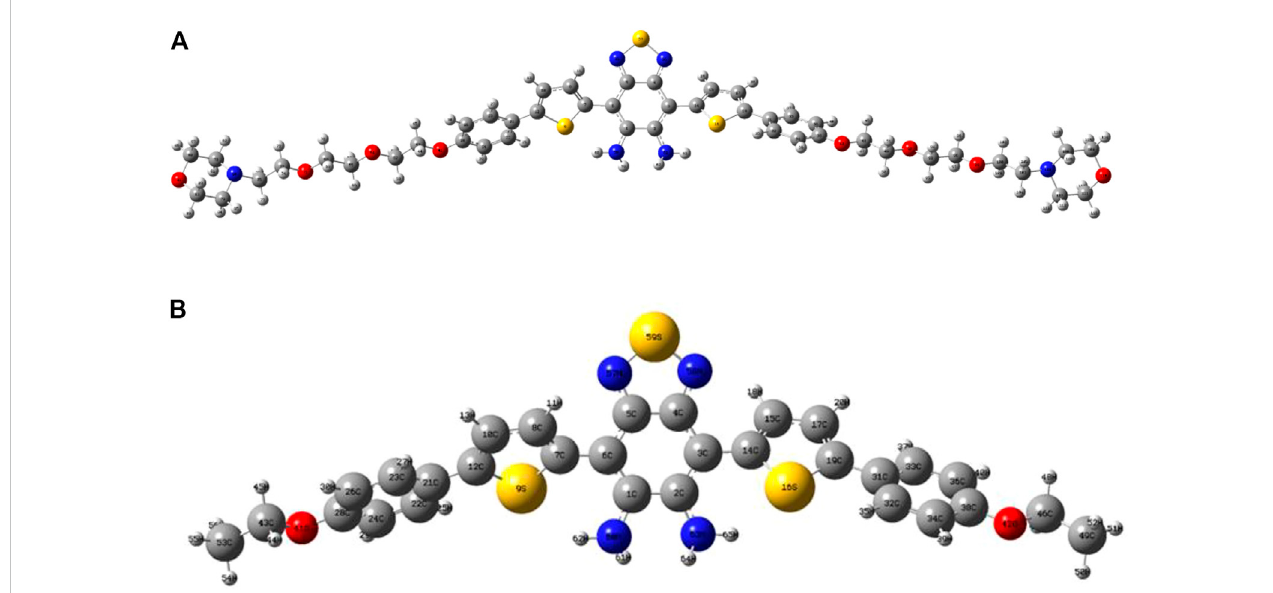
FIGURE 1 Optimized structures of (A) LS-NO and (B) DAD-NO.